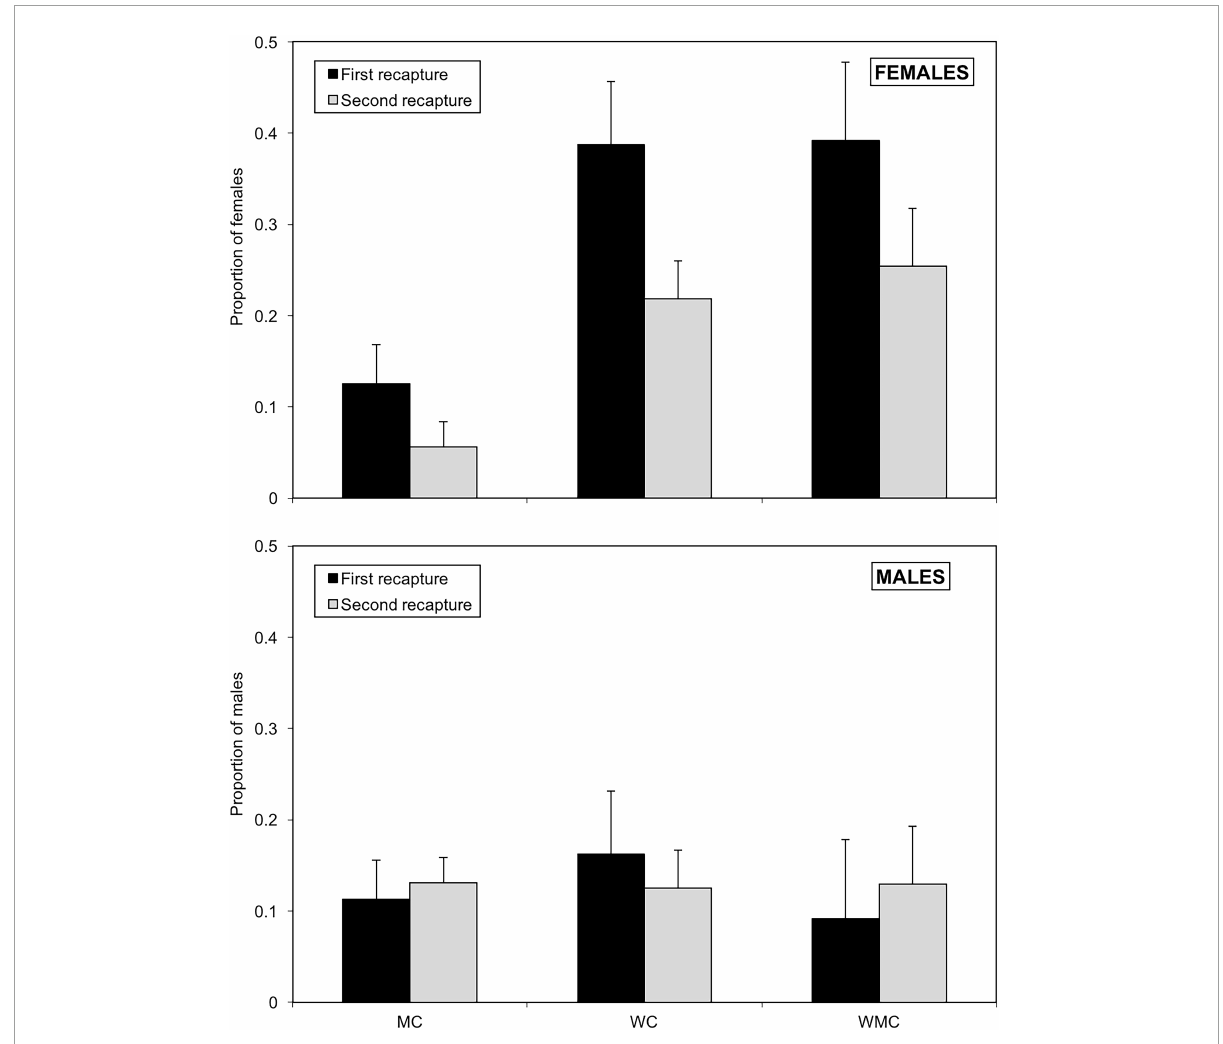
FIGURE8 Proportions with standard errors of females (upper graph) and males (lower graph) of D. hesperus persisting in three habitats (MC, WC, and WMC) composed by patches with different food resources (No prey- C-, mites- M-,